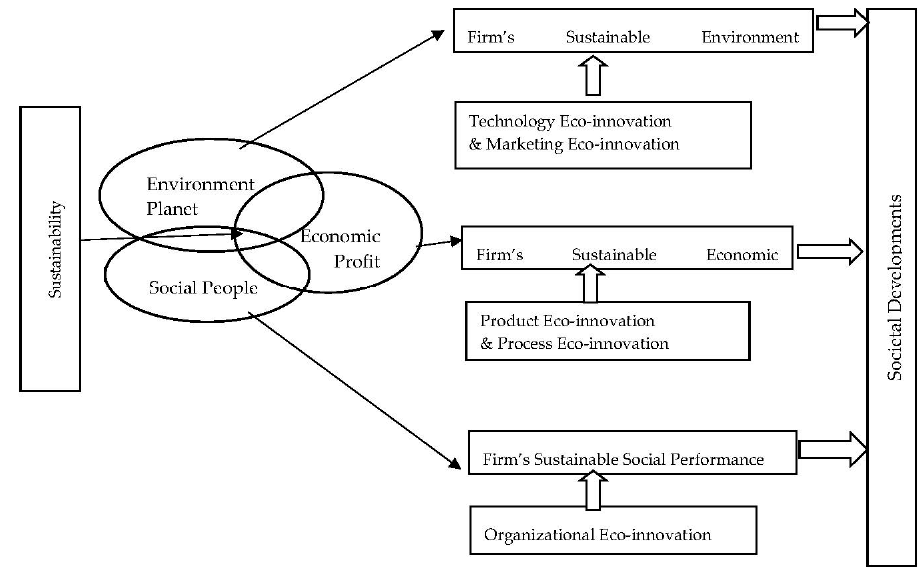
Figure 1. Sustainability and societal development through eco-innovation.